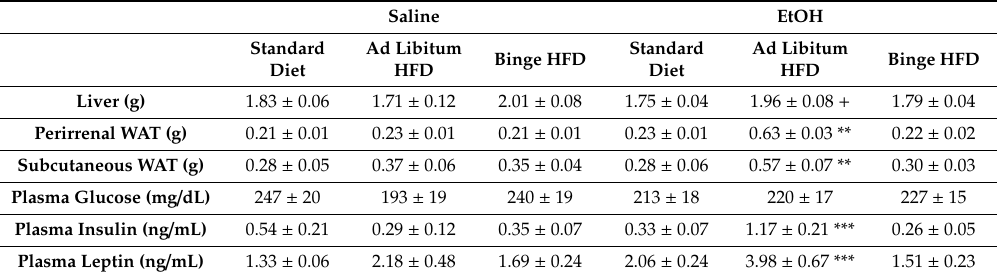
Table 1. Effect of dietary and EtOH treatments on tissues weight and plasma. Data are presented as mean (± SEM), + p < 0.05 with respect to the corresponding saline groups. ** p < 0.01, *** p < 0.001 with respect to the rest of the groups .